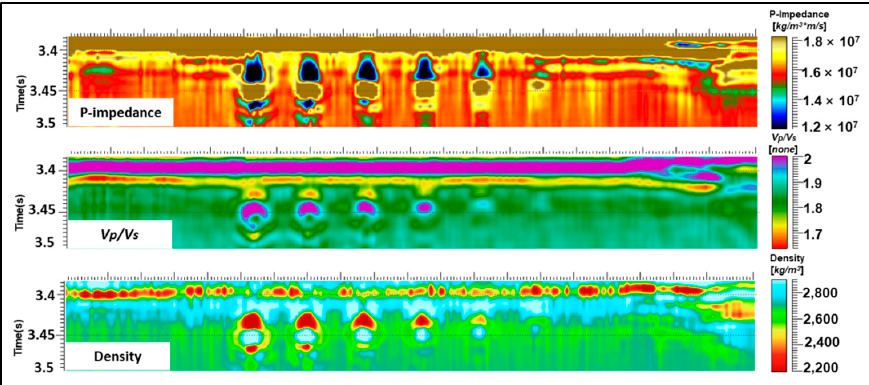
Figure 6. Seismic inverted results of geological model 1: P-impedance prediction the cave reservoir; V p / V s ratio effectively predicted in non-oil-bearing caves; density predicted a result between P-impedance and V p / V s ratio prediction.